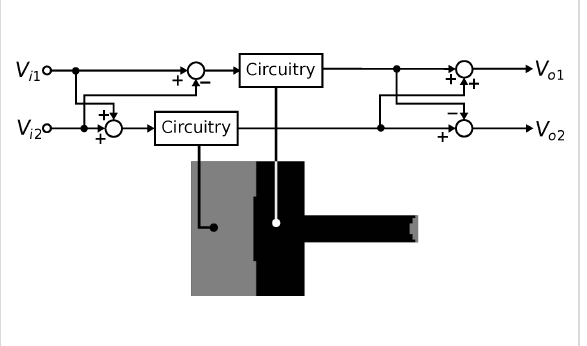
Figure 9: To perform multifrequency AFM using cantilever C2 with modes M1 and M2 simultaneously, the presented extension to the instrumentation is employed.